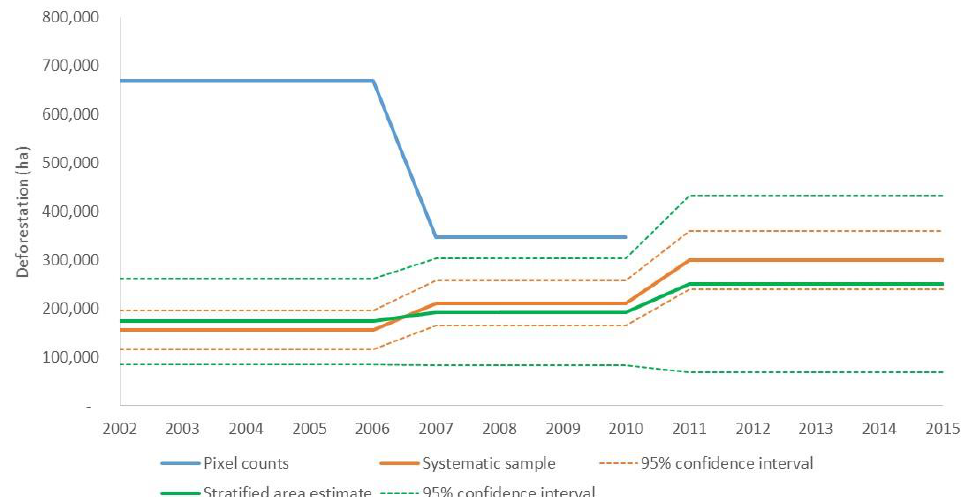
Figure 1. Mexico’s deforestation estimates using pixel counts and two sample-based methodologies, generated from data in Mexico’s reference level submissions and Mexico’s 6th national communication to the UNFCCC [43,45,46].